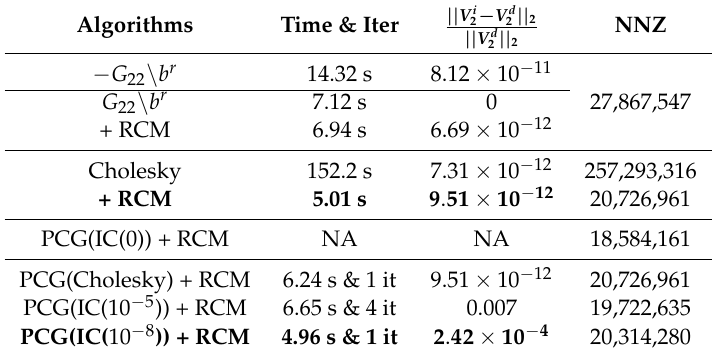
Table 3. Comparison between various numerical analysis (NA) techniques on the large linear power flow (LLPF) problem with real components Equation (13). The best results are given in the bold